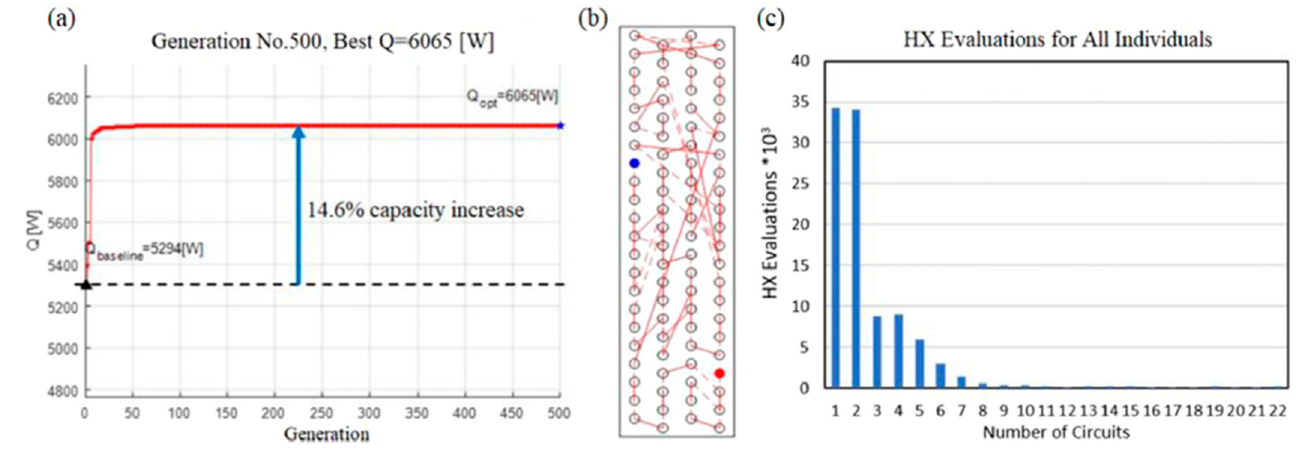
Figure 23. ( a ) Optimal circuitry configuration; ( b ) GA optimization process; ( c ) histogram of number of circuits [106].